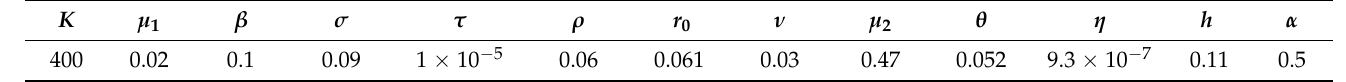
Table 4. Pessimistic parameters for forest